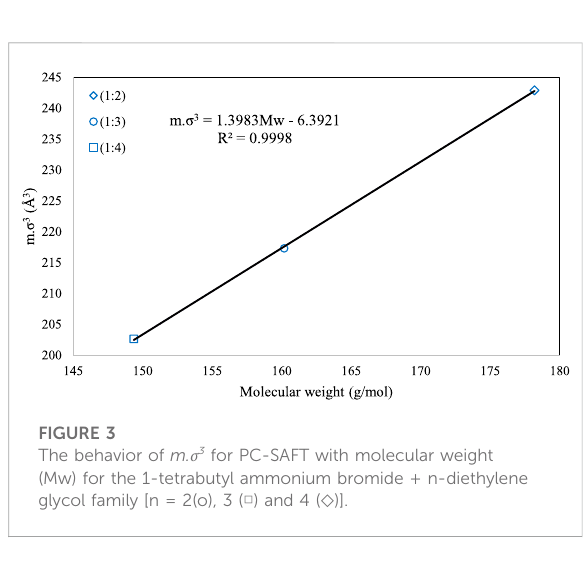
FIGURE 3 The behavior of m. σ 3 for PC-SAFT with molecular